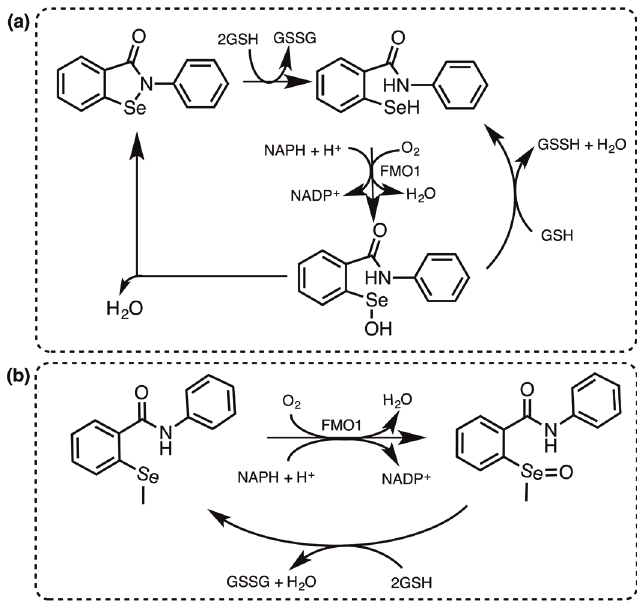
Figure 44 - Oxidation of Ebselen ( a ) and 2-(Methylseleno)benzanilide ( b ) catalyzed by FMO1 (Ziegler et al. 1992).